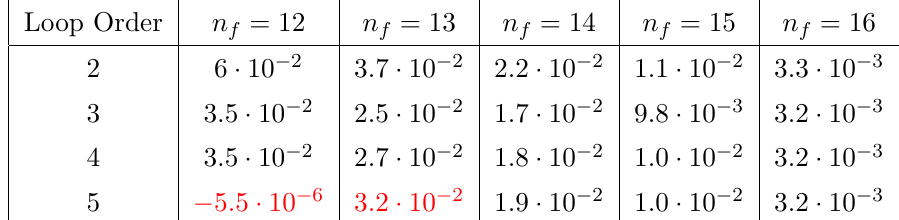
Table 1 . Approximate values of the QCD Caswell-Banks-Zaks (cid:12)xed point coupling a (cid:3) as a function of n f obtained using di(cid:11)erent loop orders. The red color indicates values that should be taken with care, because of a possible breakdown of perturbation